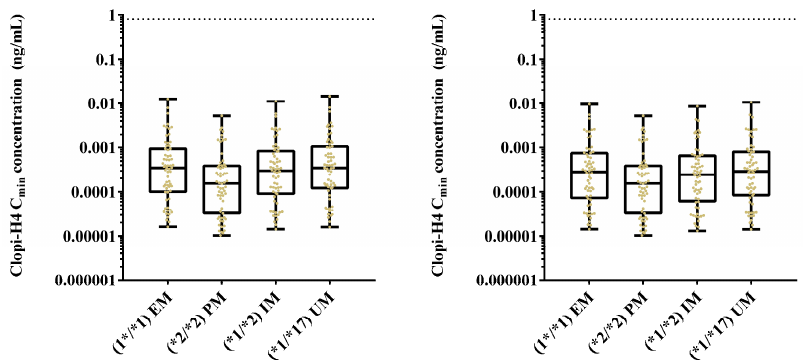
Figure 11. Impact of clopidogrel standard dose regimens on final dose clopi-H4 plasma C max (upper panels) and C min (lower panels) in Malay subjects under scenarios where mean hepatic CYP2C19 abundance is increased (left panels) or decreased (right panels) by 30%. All subjects are demarked for either all EM, PM, IM or UM populations. Box and whisker plots represent maximum, 75th percentile, median, 25th percentile and minimum clopi-H4 C max . All subjects ( n = 100 for each phenotype) received a loading dose of 300 mg on day 1, followed by daily doses of 75 mg for four days. Dashed horizontal lines represent the lower therapeutic limit for clopi-H4.